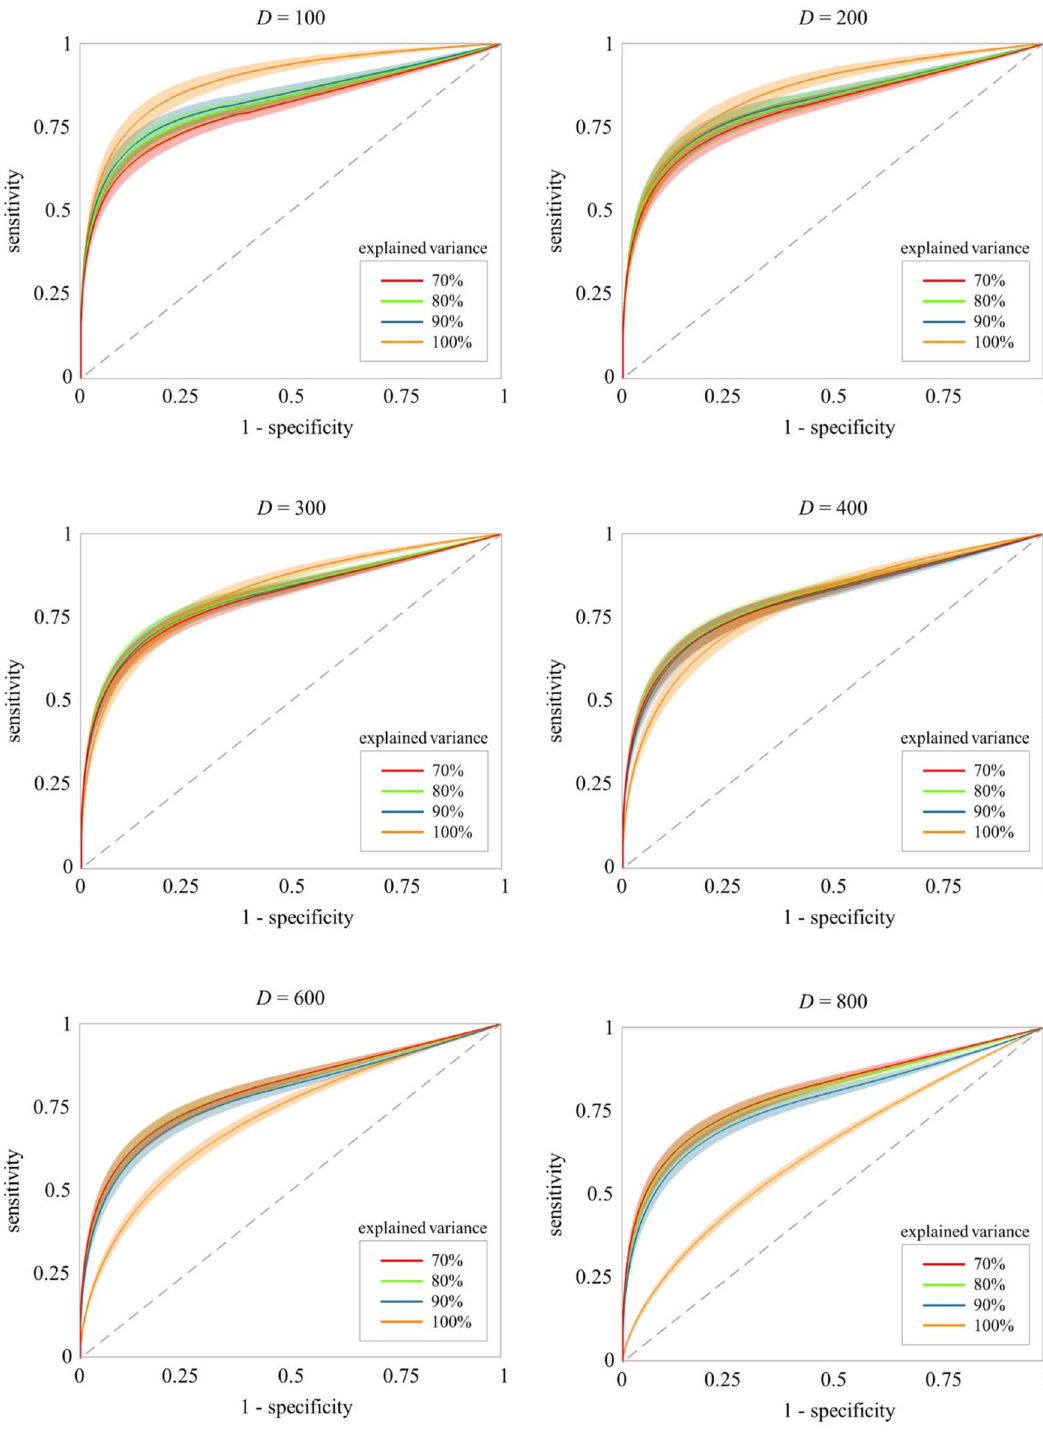
Fig 3. The lsGCI results for synthetic data: mean ROC curves (100 realizations) with standard deviation bands for D = 100,200,300,400,600,800, N = 1000, and various variance explanations. A variance explanation of 100% corresponds to the classical GCI, whereas all other shown variance explanations correspond to the